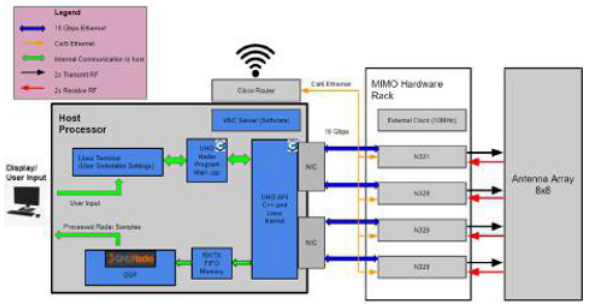
Figure 8. High level schematic of the MIMO radar, hardware components are grey and software components in blue